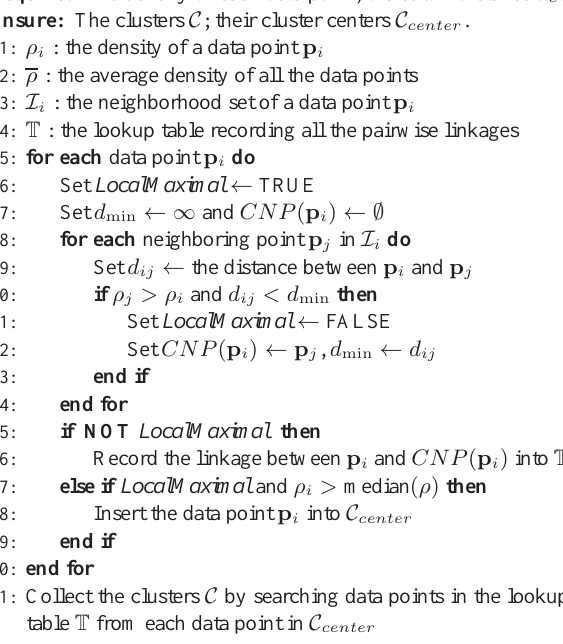
table T from each data point in C